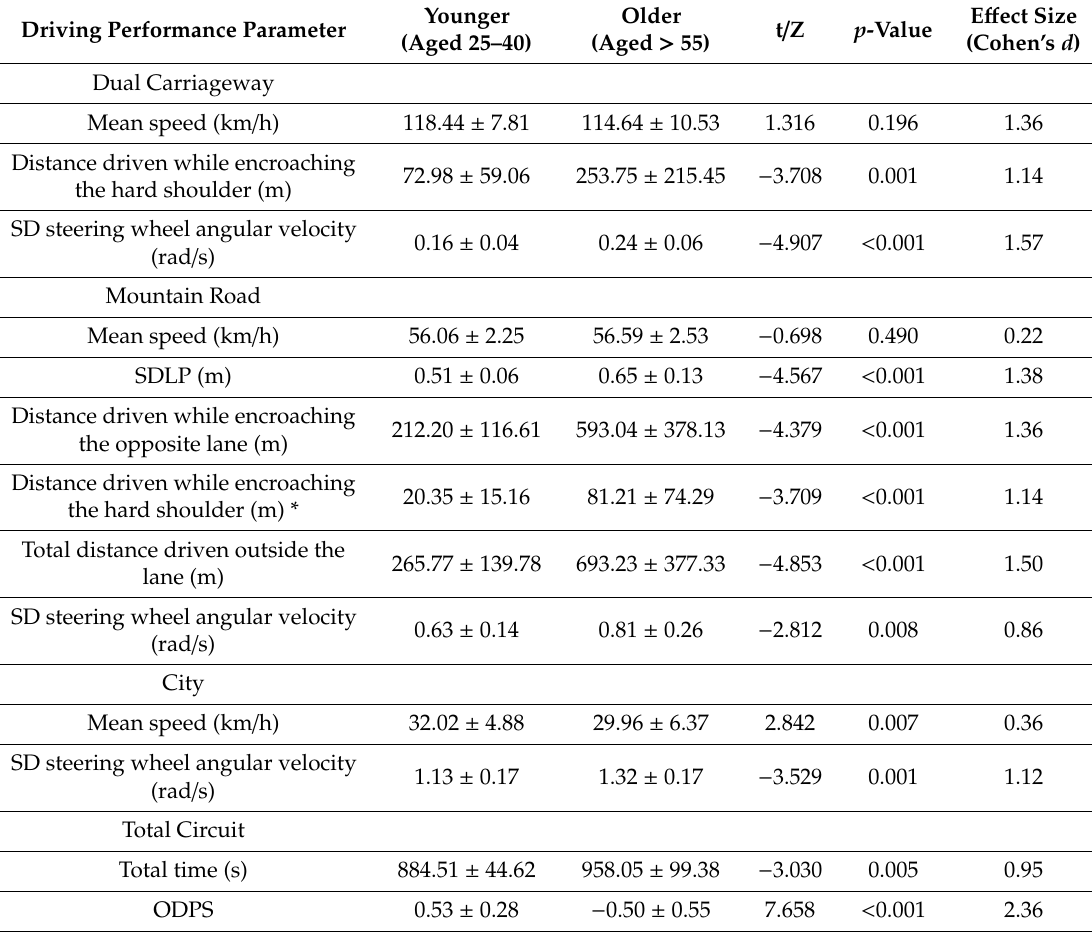
Table 3. Group mean ( ± SD) driving performance outcomes for the two age